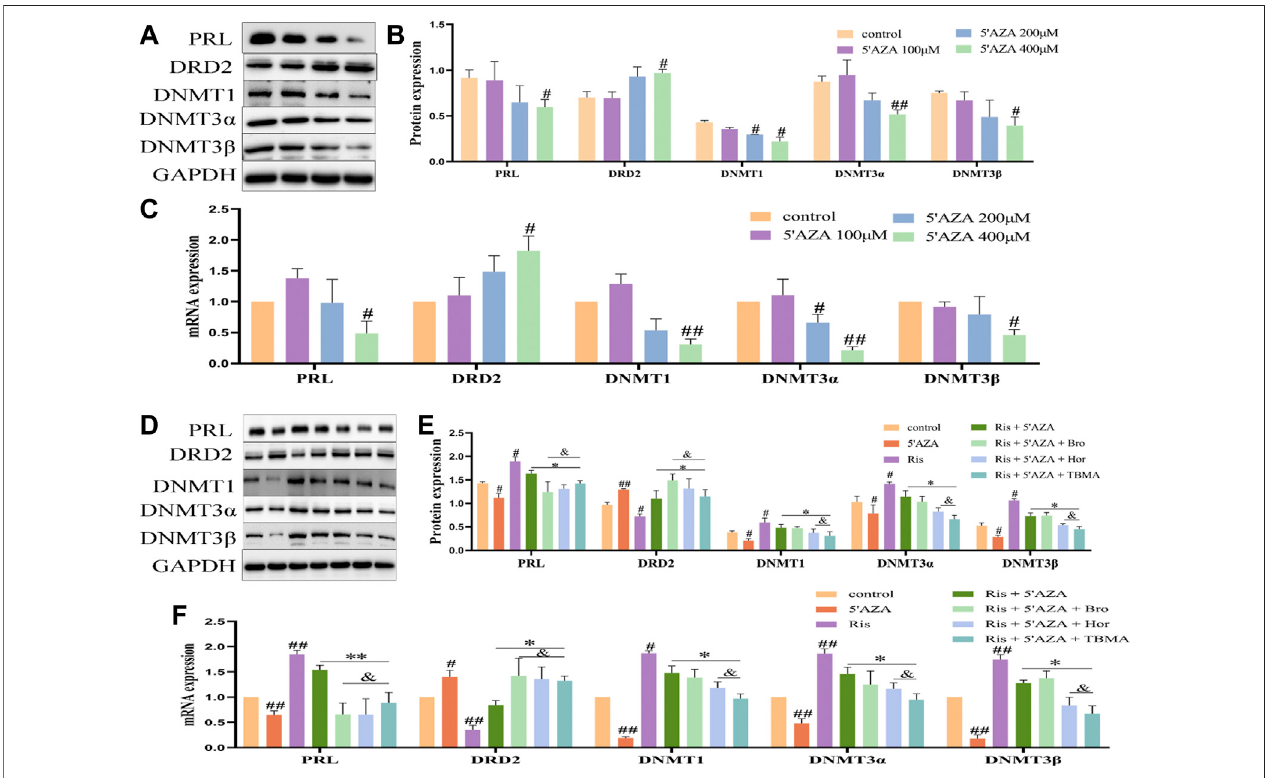
FIGURE 7 | The effects of TBMA and hordenine on DRD2 DNA methylation were enhanced by low DNMT expression levels. (A,B) PRL, DRD2, and DNMT protein expression by western blotting following treatment with different 5 ′ AZA concentrations ( n = 3). (C) PRL, DRD2, and DNMT mRNA expression by RT-PCR following treatment with different 5 ′ AZA concentrations ( n = 3; *p < 0.05 and **p < 0.01 versus the control group. (D,E) PRL, DRD2, and DNMT protein expression by western blotting following TBMA or hordenine treatment of MMQ cells ( n = 3). (F) PRL, DRD2 and DNMT mRNA expression by RT-PCR following TBMA or hordenine treatment of MMQ cells ( n = 3). Dataare presented asthe mean ± SD ( # p < 0.05 and ## p < 0.01 versus the control group; *p < 0.05 and **p < 0.01 versus the Risgroup; & p < 0.05 versus the Ris +5 ′ AZA group. 5 ′ AZA = 5-Aza-2 ′ -deoxycytidine; Hor = hordenine; Ris = risperidone; TBMA = total barley maiya